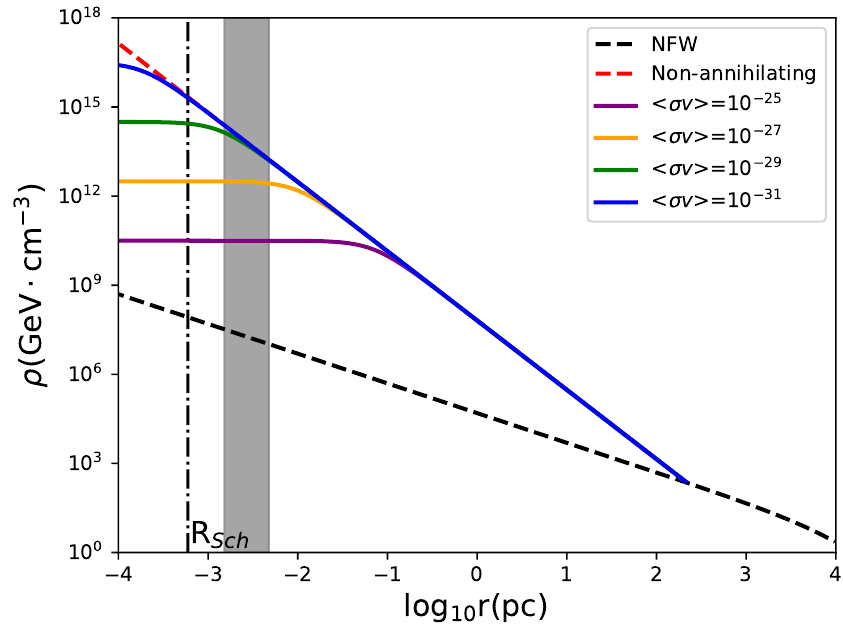
Figure 1 . Dark Matter Density Profile of M87 ? . Density distribution for an NFW halo profile (black dashed) with δ = 1 and the same halo with a spike in the central region for a non-annihilating DM (red dashed). Also shown are DM with m χ = 100 GeV and thermally average annihilation cross section h σv i = 10 − 31 , 10 − 29 , 10 − 27 , and 10 − 25 cm 3 s − 1 (blue, green, orange and purple solid line), respectively. The dot-dashed black vertical line shows corresponding Schwarzschild radius of M87 ? , and the gray shadowed region corresponding to the areas covered by EHT observation. In this plot, the lifetime of SMBH is chosen with 10 9 years and R sp ’ 220